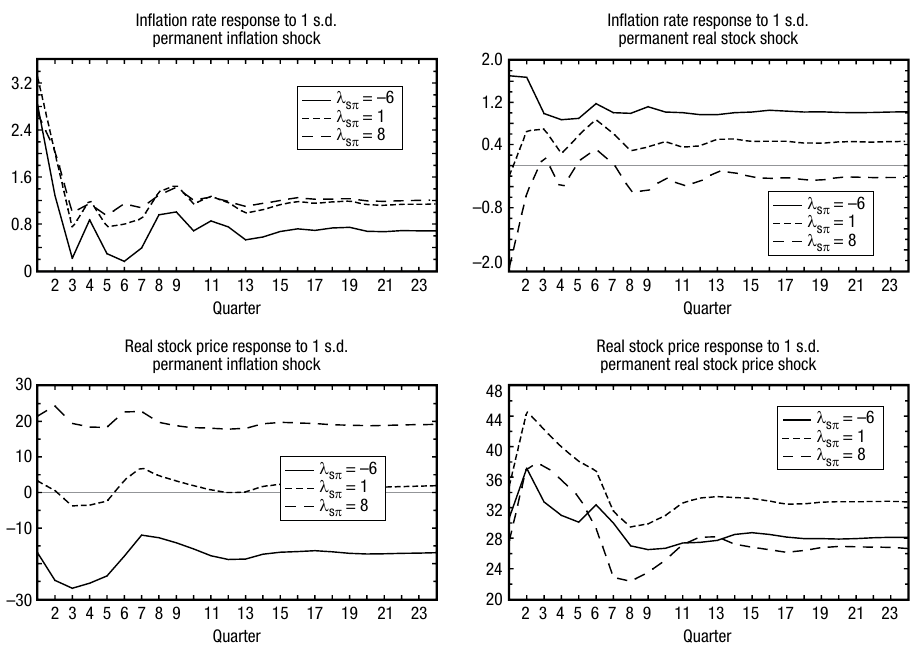
Fig. 3. Inflation and real stock price impulse responses for different assumed l